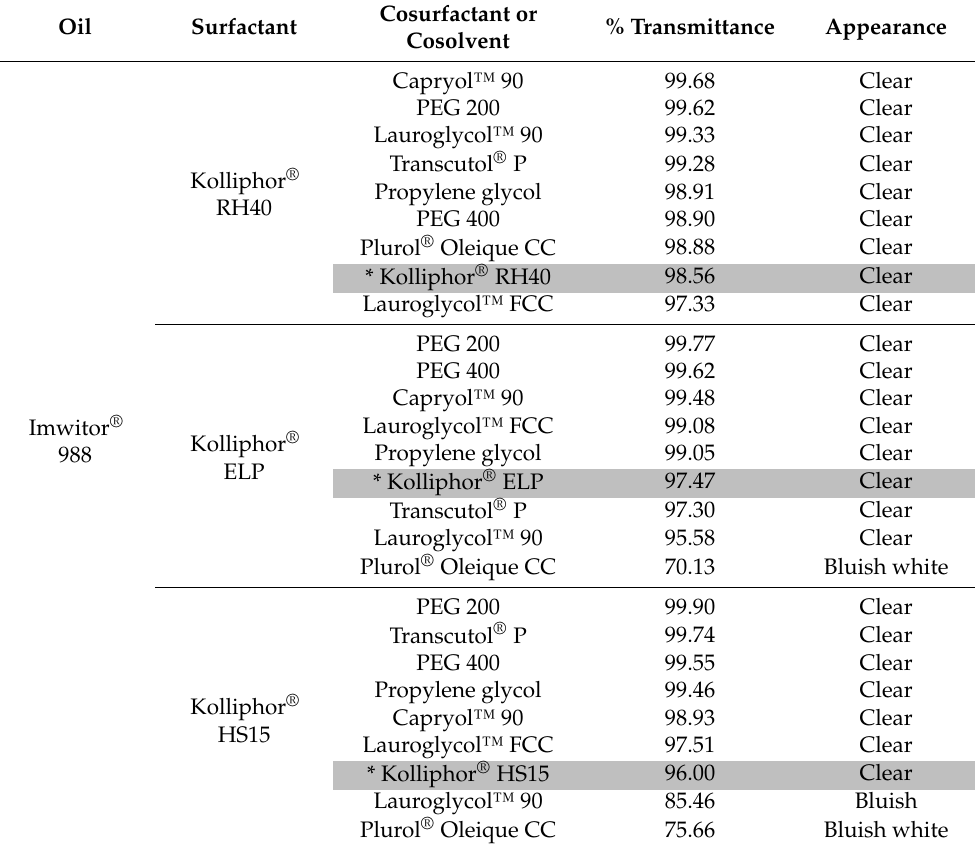
Table 2. Results of cosurfactant and cosolvent screening for Imwitor ®